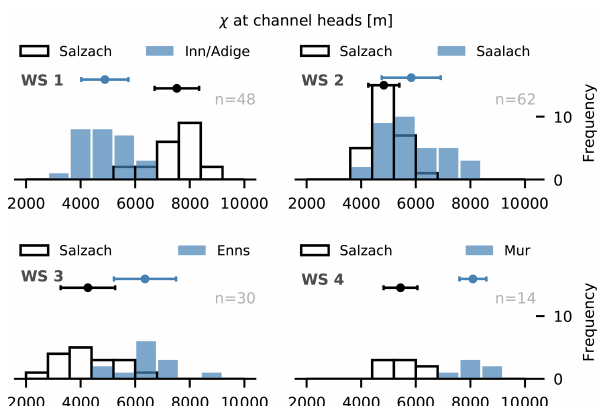
Figure 3. The χ values measured at channel heads of the inves- tigated catchments. Histograms with a black outline represent the Salzach drainage basin. Histograms with a blue filling represent the adjacent Inn–Adige (WS 1), Saalach (WS 2), Enns (WS 3) and Mur (WS 4) drainage basins with n as the total number of data points. Data are divided into 10 equally spaced bins. Error bars in- dicate the standard deviation, and filled circles are the mean values of the